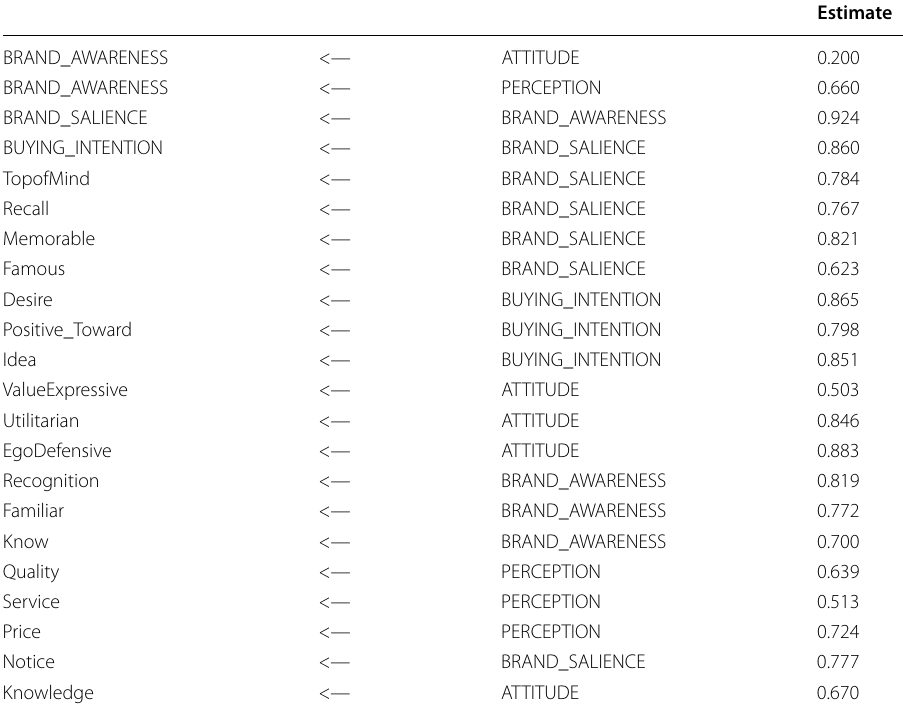
Table 4 Standardized regression weights: (Group No. 1—default model)